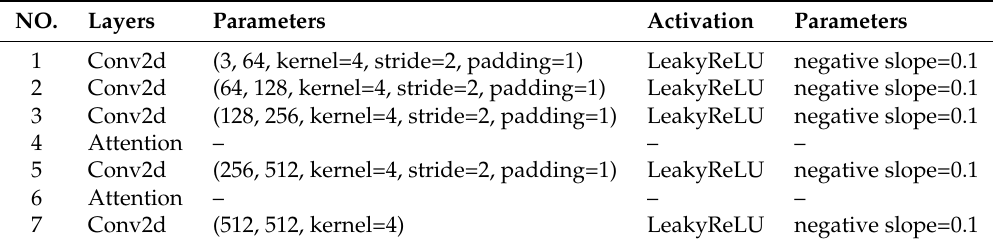
Table 2. Query/Key encoder